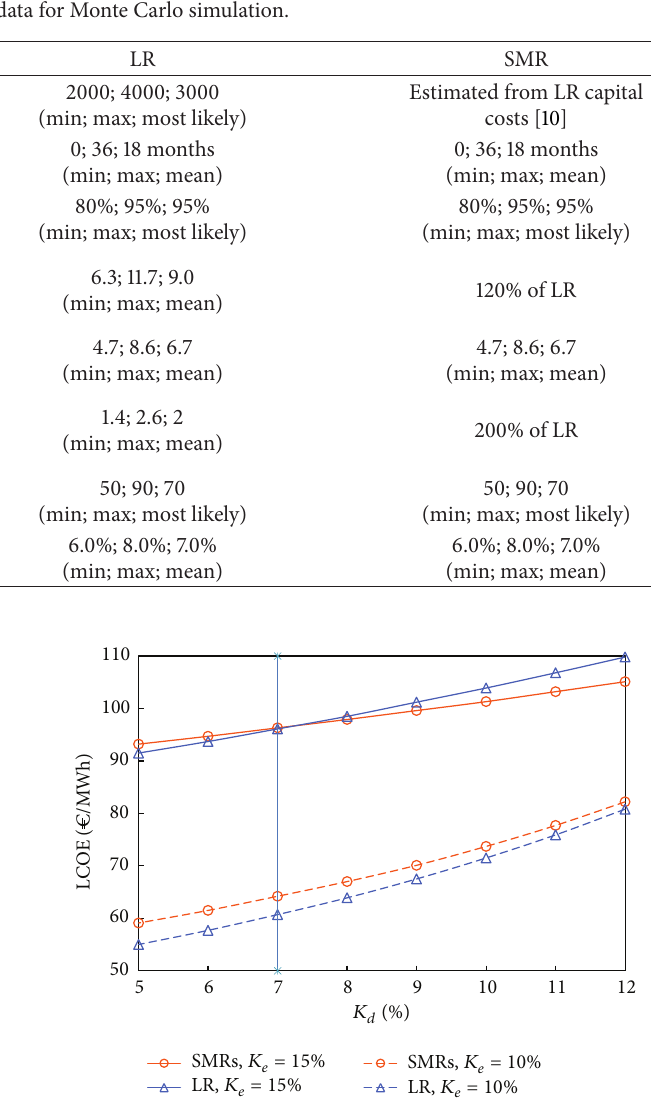
Figure 9: LCOE trend with increasing cost of debt ( 𝐾 𝑑 ) and different cost of equity ( 𝐾 𝑒 ) (adapted from